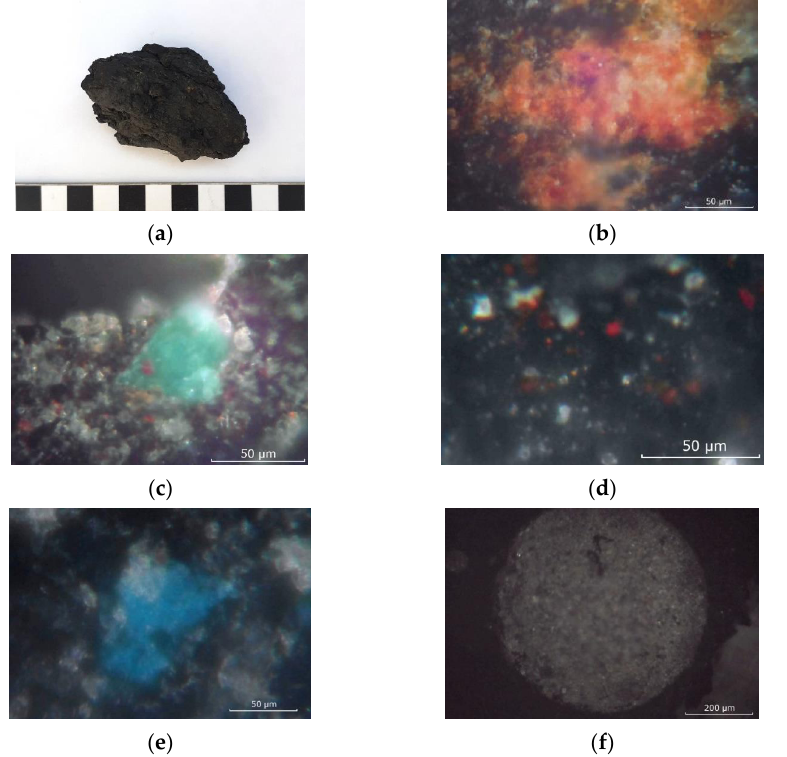
Figure 2. Temesa 1: ( a ) rock sample; ( b ) goethite lump (reflected light micrograph, crossed polarizers); ( c ) melantherite microcrystal surrounded by cuprite microcrystals (reflected light micrograph, crossed polarizers); ( d ) cuprite microcrystals (reflected light micrograph, crossed polarizers); ( e ) sample aliquot heated at around 600 °C in oxidant atmosphere: chalcanthite crystal (reflected light